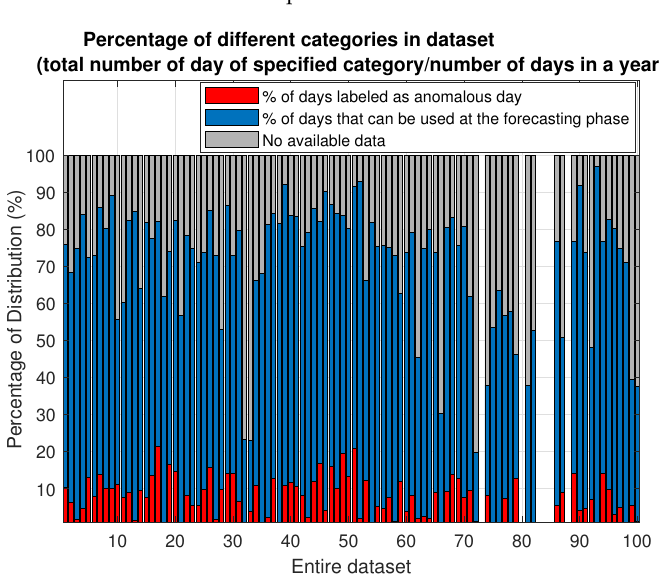
Figure 6. Percentage of different categories in